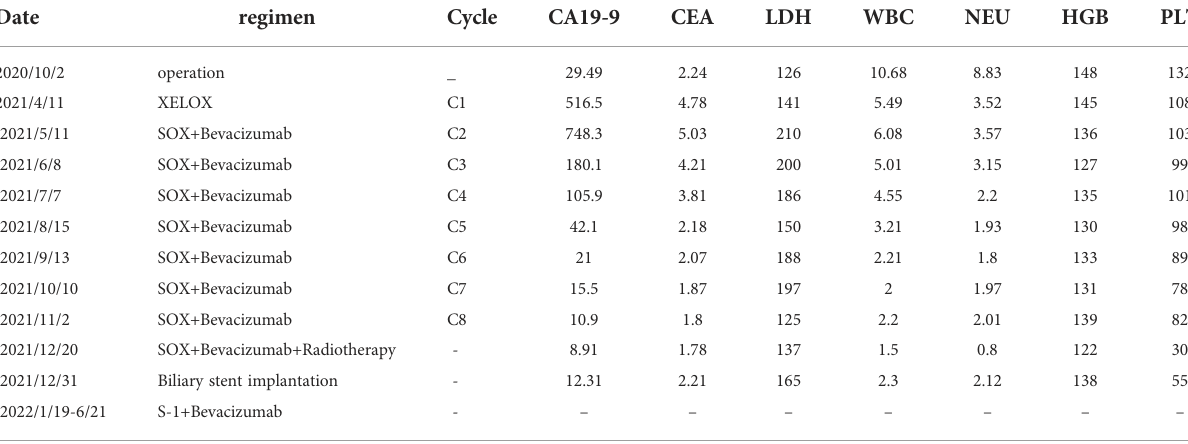
TABLE 1 The whole treatment process of the patient ,including date, treatment regimen, cycle and the changes of hematological indicators (CA19-9, CEA, LDH, WBC, NEU, HGB and